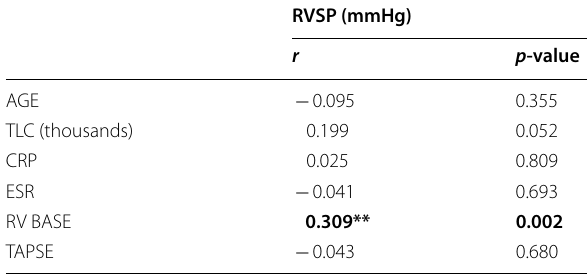
Table 3 Factors influencing pulmonary artery pressure Table 4 Logistic regression analysis of factors influencing